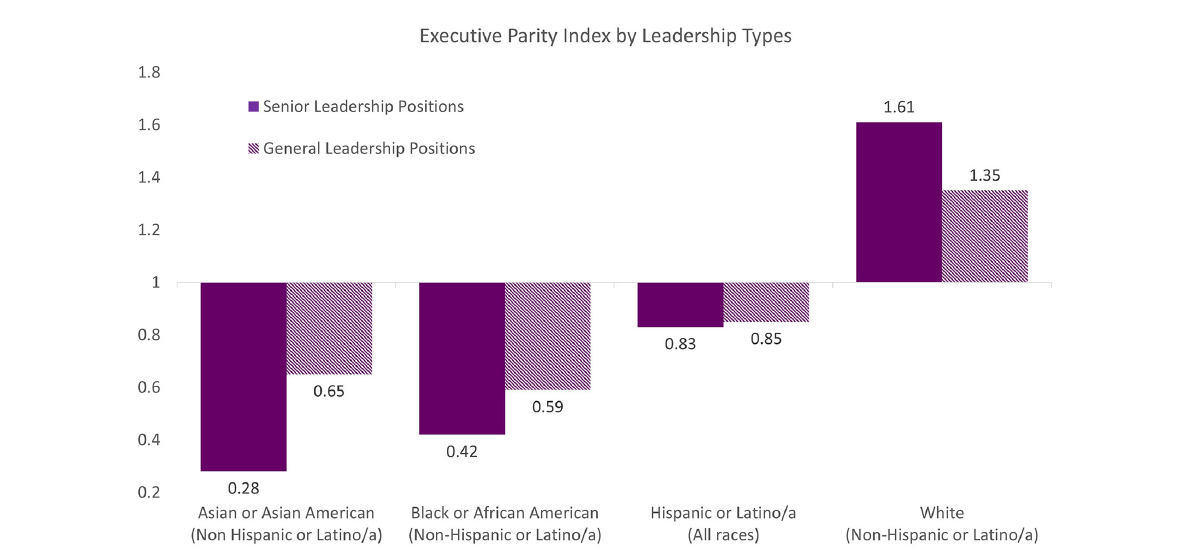
FIGURE1 The Executive Parity Index (EPI) is a metric created by Ascend, a non-profit Pan-Asian business professional organization, to illustrate the ratio of one group’s representation at the executive level of an organization versus its representation at the relevant professional level. An EPI value of 1.0 indicates that the group’s representation at the level of interest is at parity with those of the relevant professional level. An EPI less than 1.0 indicates there is underrepresentation at the level of interest, or lower than expected, in reference to their representation at the relevant pool. In contrast, an EPI greater than 1.0, indicates there is overrepresentation, or more than expected, in reference to their representation in the relevant